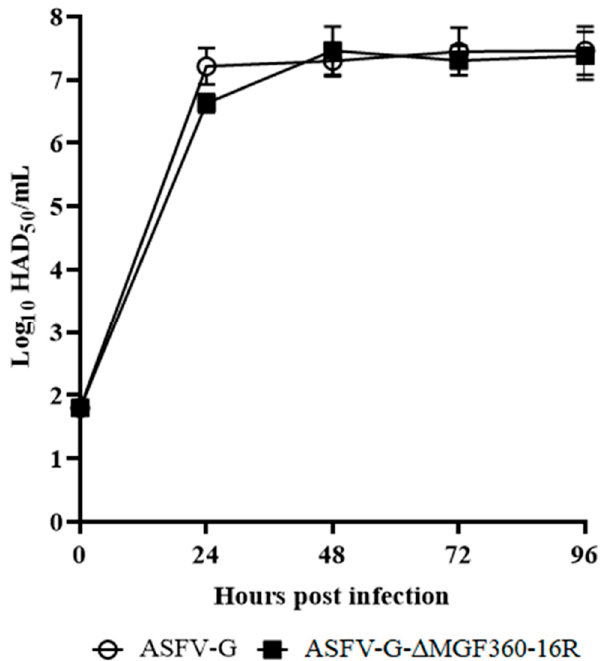
Figure 7. In vitro growth kinetics in primary swine macrophage cell cultures infected (MOI = 0.01) with either ASFV-G-MGF360-16R or parental ASFV-G virus. Samples were taken from three independent experiments at the indicated time points and titrated. Data represent means and standard deviations. The sensitivity using this methodology for detecting virus was > log 10 1.8 50% hemadsorbing doses per ml (HAD 50 / mL).